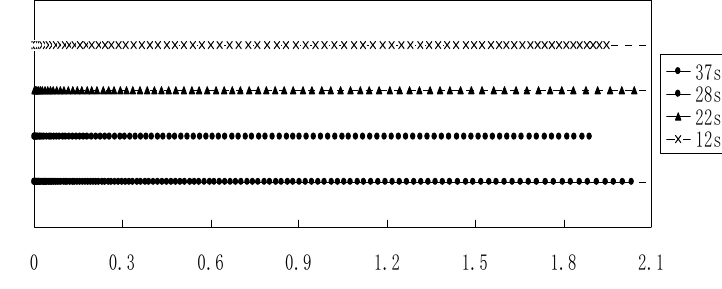
ff erent runtimes.